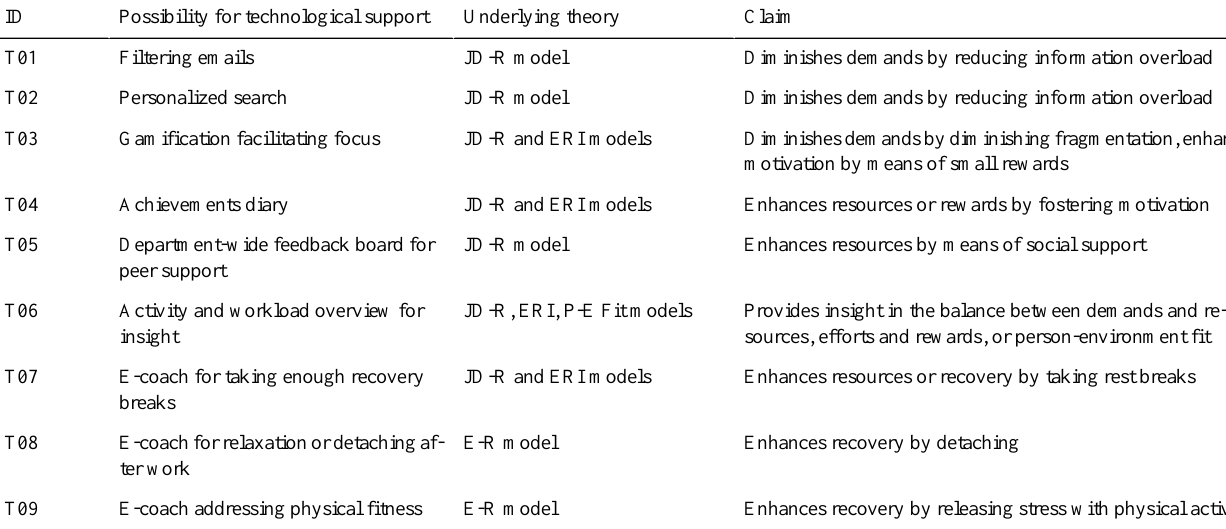
Table 1. Overview of identified technologies and associated